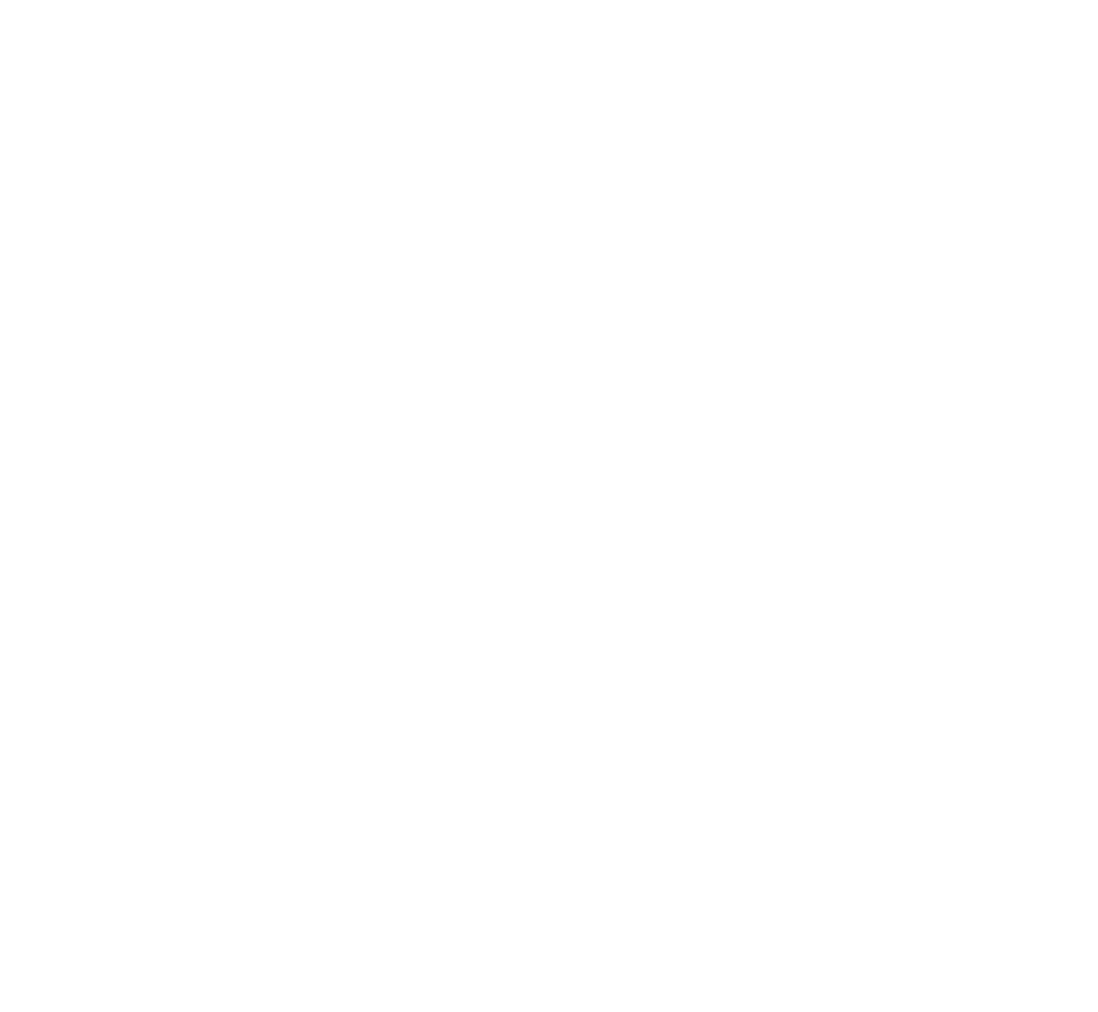
Figure 1. Equipment used: multisensory CMM (a), laser scanner (b) Figure 2. Measuring procedure Figure 3. SG1 and SR1 reference systems Figure 4. Aligning the CAD and real models for nose car Figure 5. Points acquired for two zones of interest Figure 6. CAD model (a), scanned model (b) and deviation analysis between model and scanned surface (c) Figure 8. Digitization of Formula One car Figure 9. Using Deviation Analysis tool for symmetry check Figure 10. Digitization process (partial results) of Formula One nose car Figure 11. Frequency of overall standard deviation (a) and fre- quency of independent standard deviations for each axis (b) Figure 12. Statistical data for zone 1 of nose car Figure 13. Statistical data for zone 2 of nose